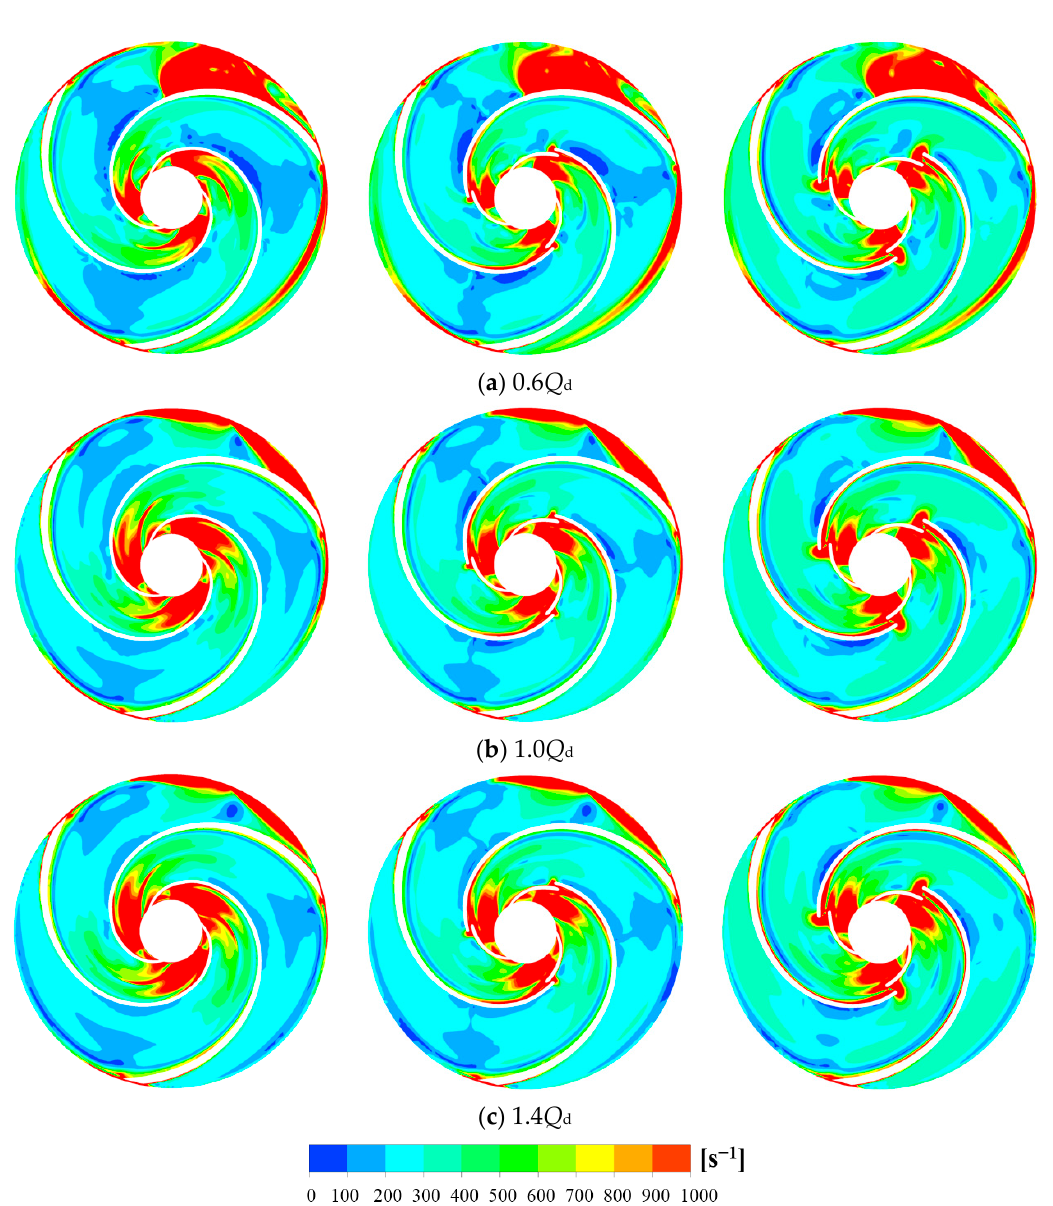
Figure 12. Distribution of shear strain rate in the middle section of impeller. From left to right: Model 1, Model 2, and Model 3.